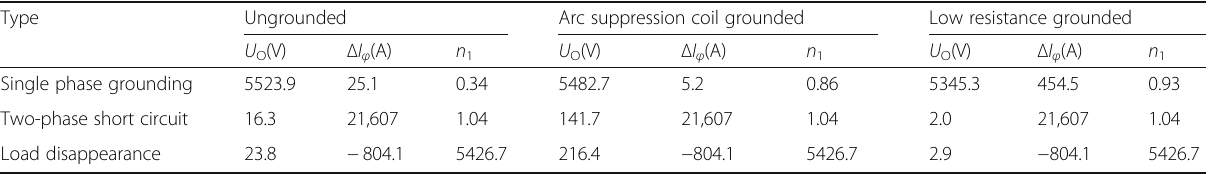
Table 6 Protection characteristic parameters in other cases